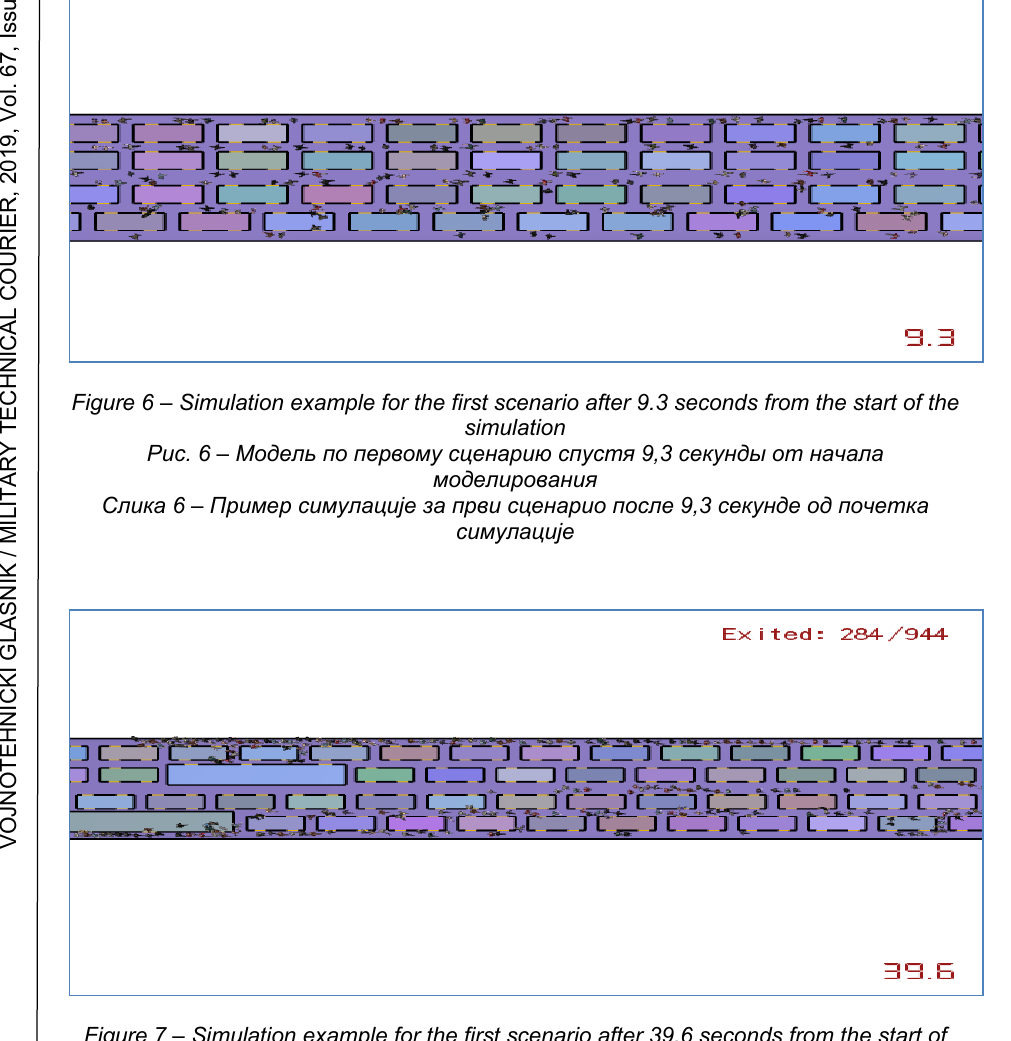
Figure 7 – Simulation example for the first scenario after 39.6 seconds from the start of the